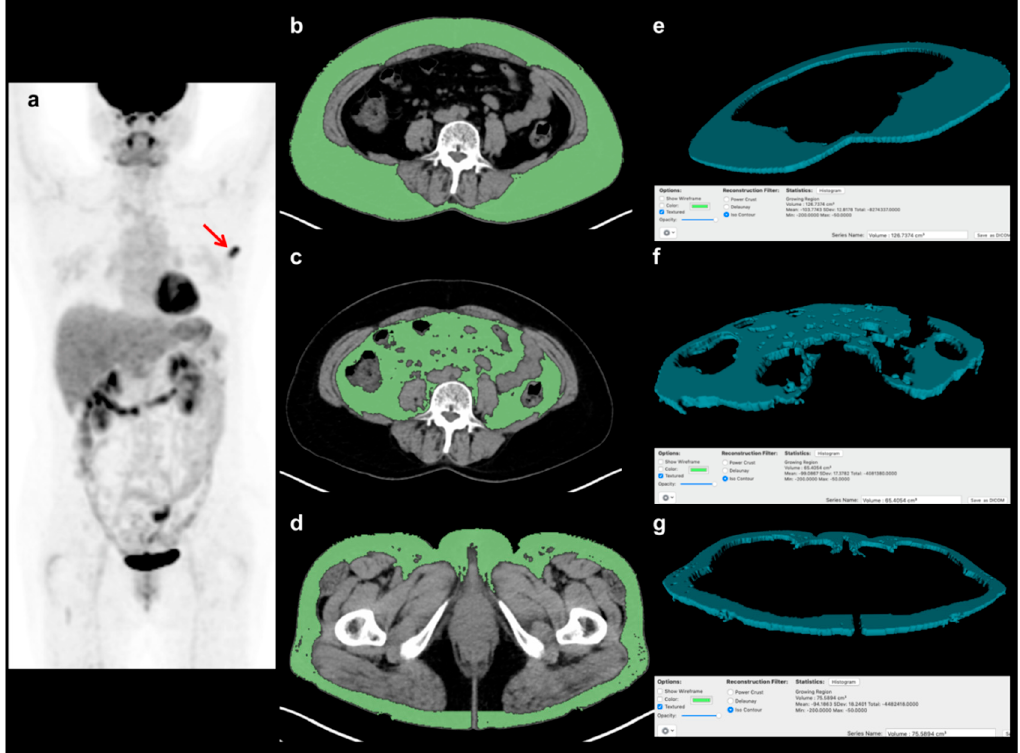
Figure 1. Example of the measurement of volume and CT-attenuation of visceral adipose tissue (VAT), abdominal subcutaneous adipose tissue (SAT), and gluteofemoral adipose tissue (AT). A 57-year-old woman with breast cancer underwent staging FDG PET / CT, showing focally increased FDG uptake at the left breast in a maximum intensity projection image ( a ) (arrow). Using three consecutive transaxial CT images of FDG PET / CT, the areas of VAT, abdominal SAT, and gluteofemoral AT were delineated using a CT-attenuation range of − 200 to − 50 HU at ( b ) the L4–5 spine level for VAT and ( c ) abdominal SAT, and ( d ) at the proximal femur level for gluteofemoral AT. Based on the areas of each AT in the CT images, ( e ) the three-dimensional structure of VAT, ( f ) abdominal SAT, and ( g ) gluteofemoral AT were automatically created, and their volume and CT-attenuation values were calculated.